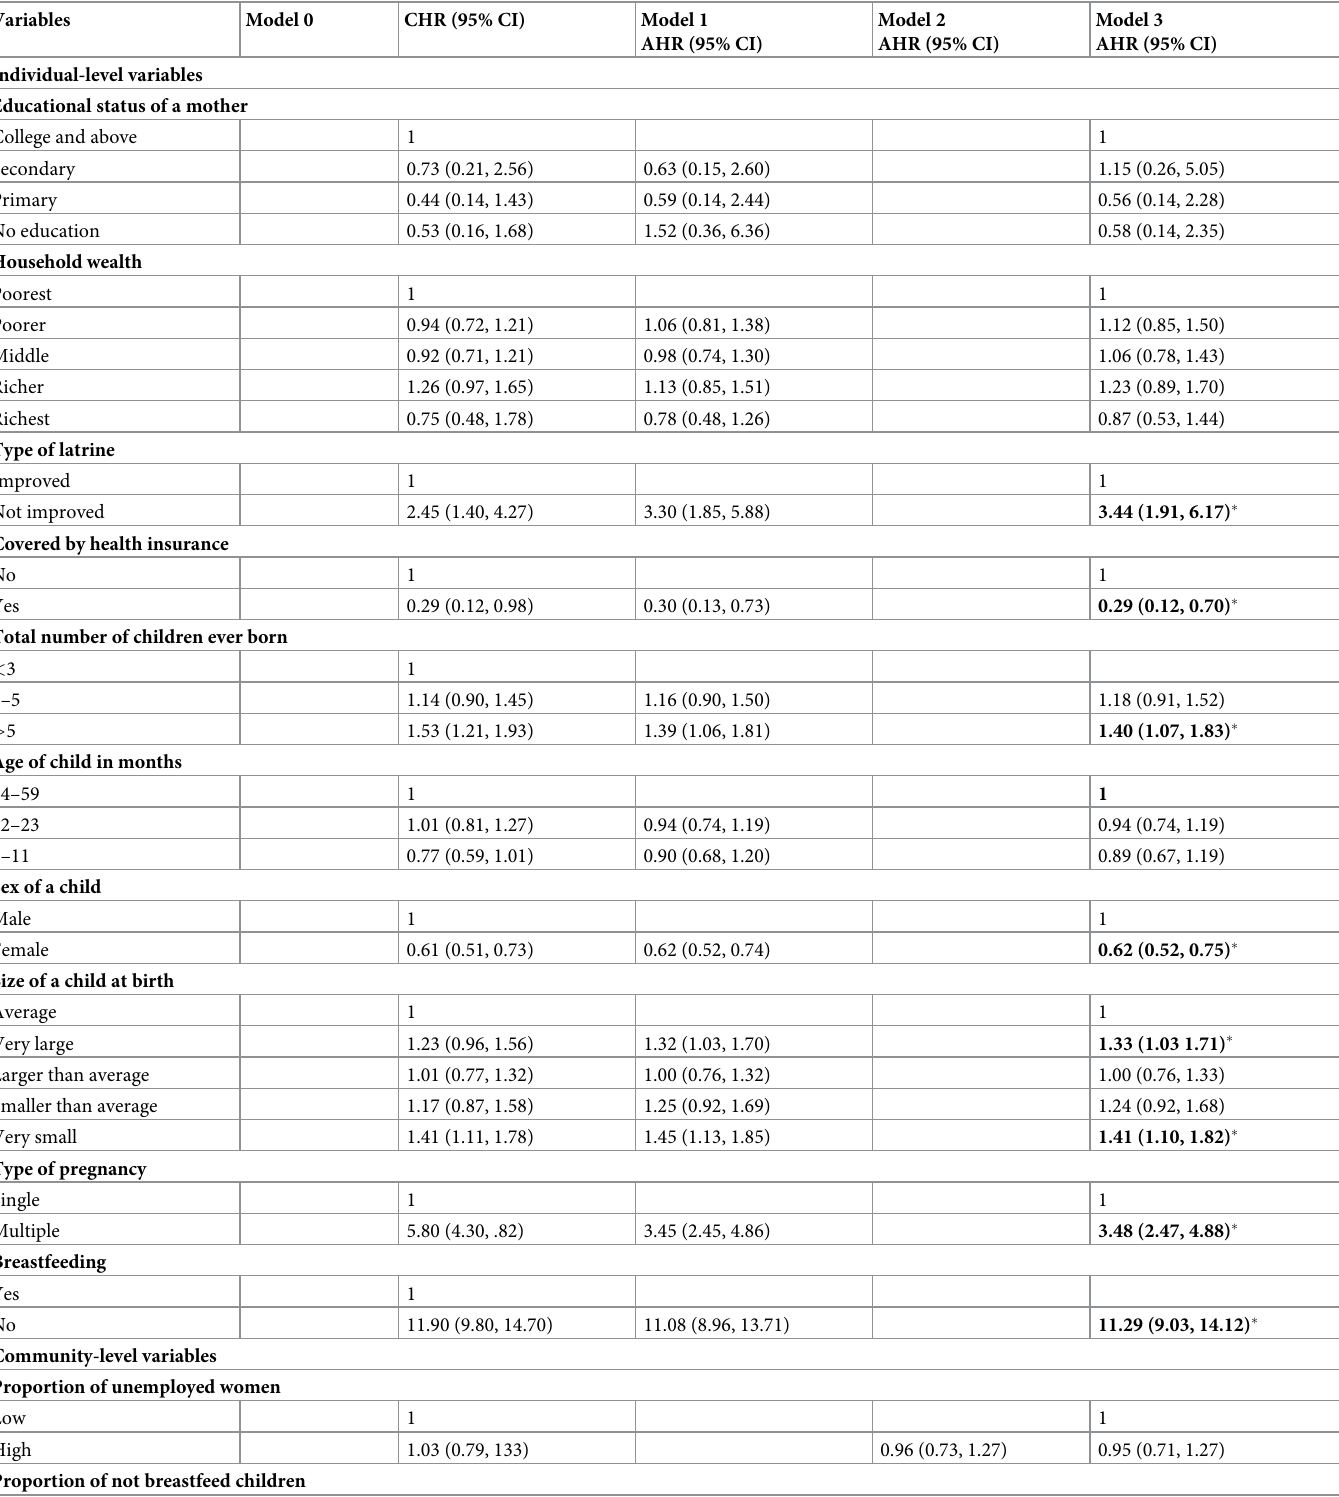
Table 4. Cox-gamma shared frailty model for predictors of under-five mortality in rural Ethiopia, EDHS